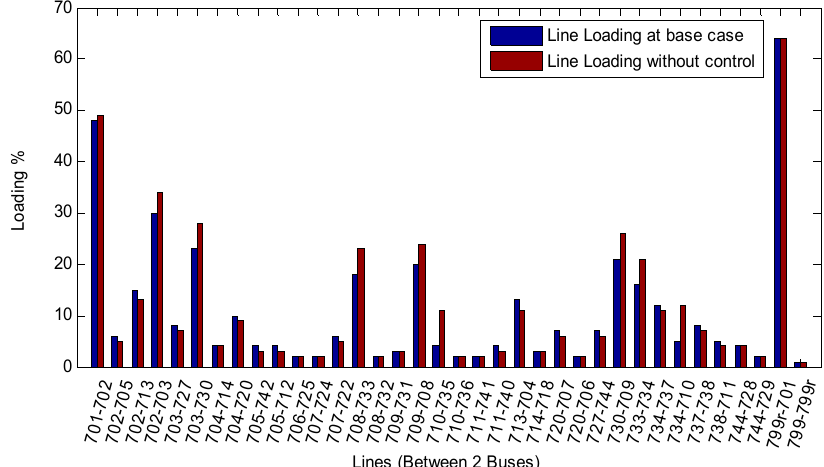
Figure 16. Line loading at base case and without charging control (dumb charging).